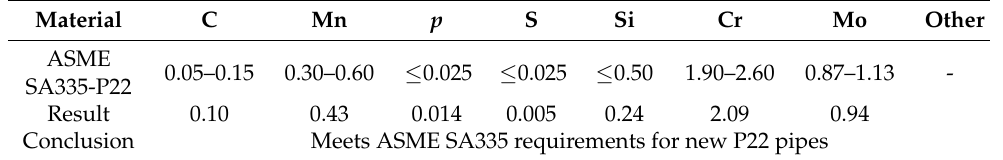
Table 2. Chemical composition (wt).